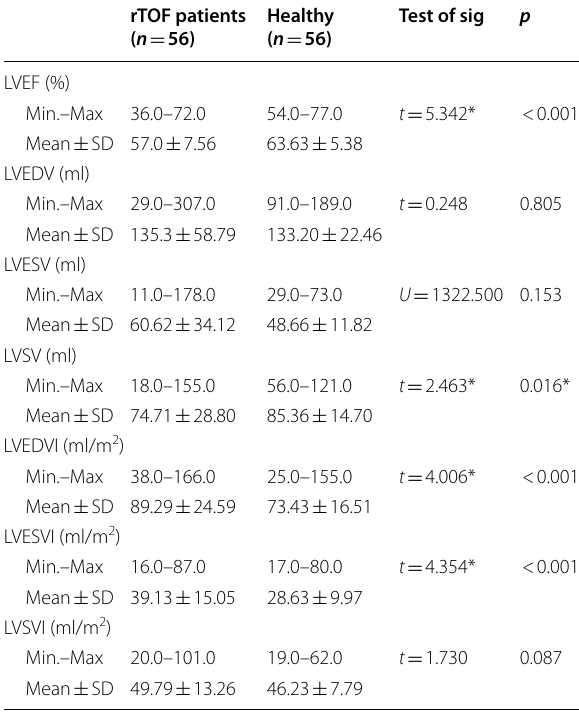
Table 7 Comparison between the two studied groups (56 rTOF patients and 56 healthy volunteers) regarding different CMR RV volumetric and function indices